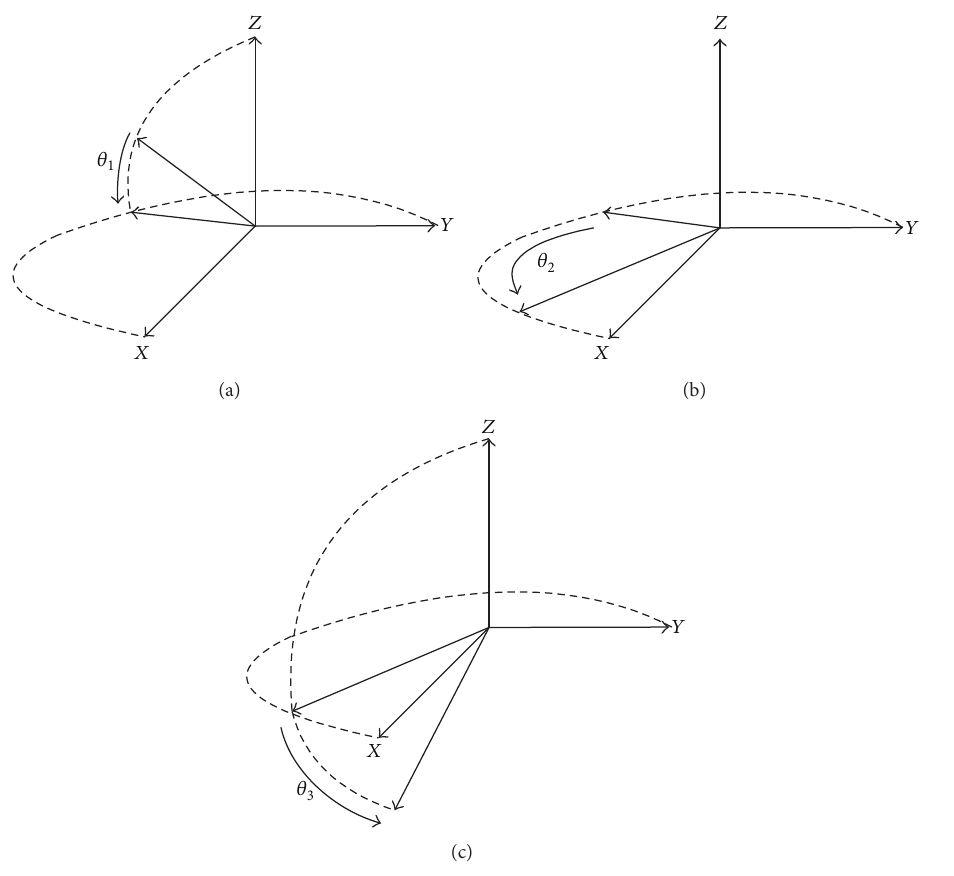
Figure 4: Decomposition of fall rotation quaternion Q . (a) Quaternion Q 1 . (b) Quaternion Q 2 . (c) Quaternion Q 3